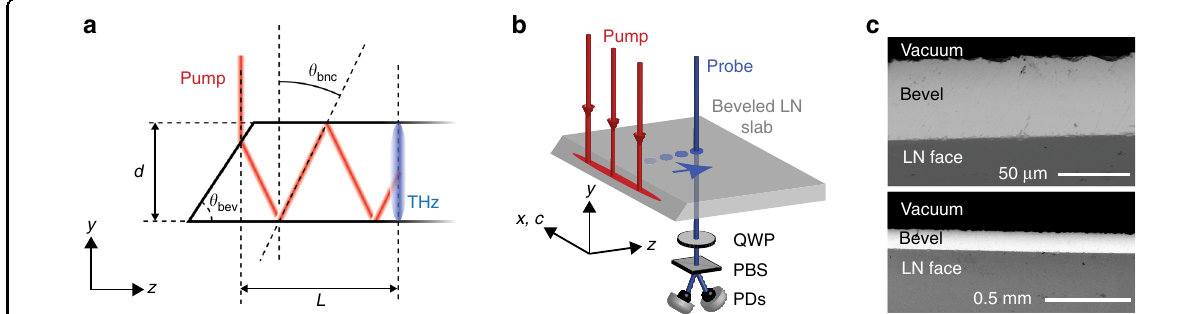
Fig. 1 Experimental geometry and sample images. a Schematic illustration of beveled LN slab with thickness d . Pump light is incident at the bevel angle θ bev with respect to the bevel normal and refracts into the crystal at “ bounce ” angle θ bnc . Buildup distance for THz generation is denoted as L . b Diagram of experimental geometry. The LN slab is oriented with the optic axis (c-axis) parallel to the beveled edge. The c-polarized pump pulse is fi xed on the bevel and the THz fi eld is sampled at multiple distances from the bevel. After passing through the sample the probe pulse is sent through a quarter wave plate (QWP) and a polarizing beamsplitter (PBS), and then measured on balanced photodiodes (PDs). c SEM images of beveled edge of LN slab at two different scales. The slab is viewed from the top down (the y -direction as de fi ned in ( b )). The light gray region shows the beveled edge and the dark gray region below it shows the face of the LN